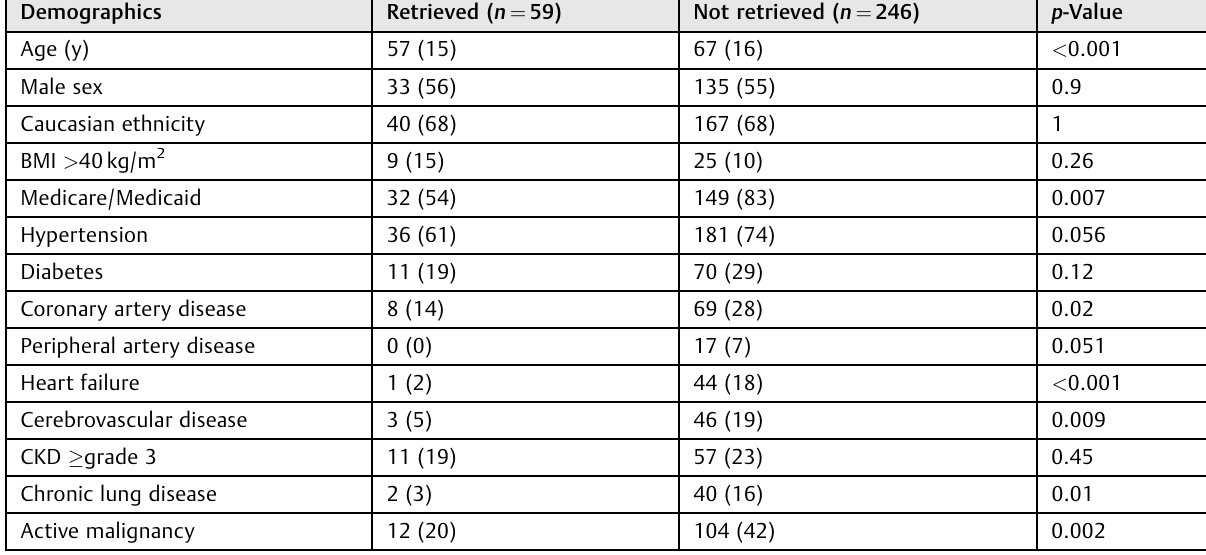
Table 2 Demographics and baseline characteristics of patients with